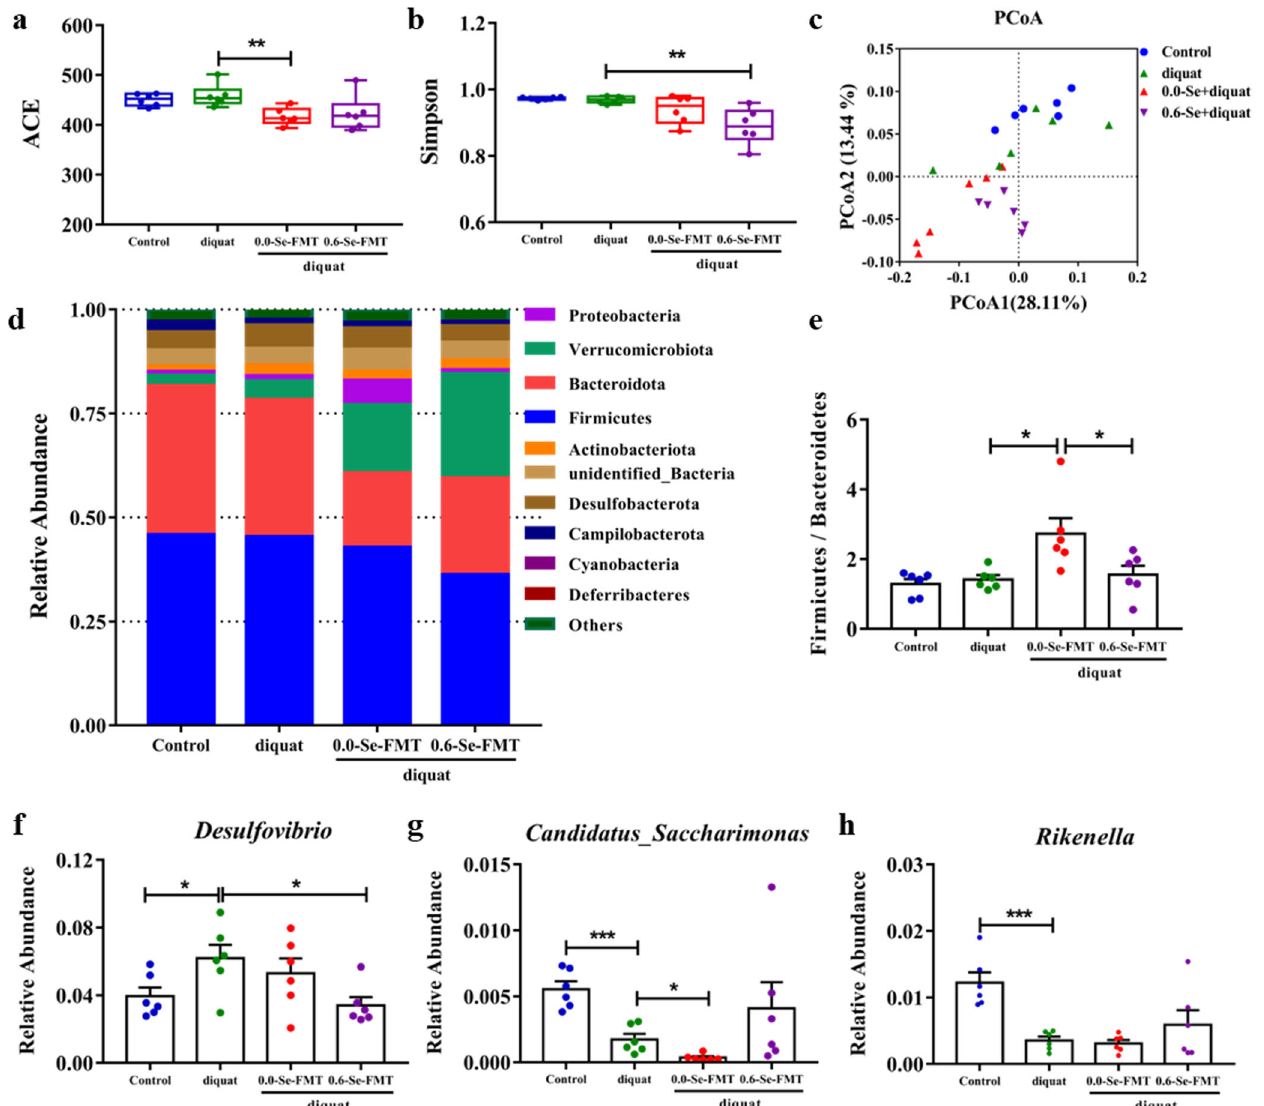
Fig. 9 Effects of FMT on gut microbiota in mice exposed to diquat. a , b Alpha diversity index ( n = 6). c PCoA ( n = 6). d The relative abundance composition of gut microbiota at the phylum level ( n = 6). e Ratio of Firmicutes to Bacteroides ( n = 6). f – h Differences in gut microbiota between the genus level ( n = 6). Data are expressed as mean ± SEM. * P < 0.05; ** P < 0.01; *** P <